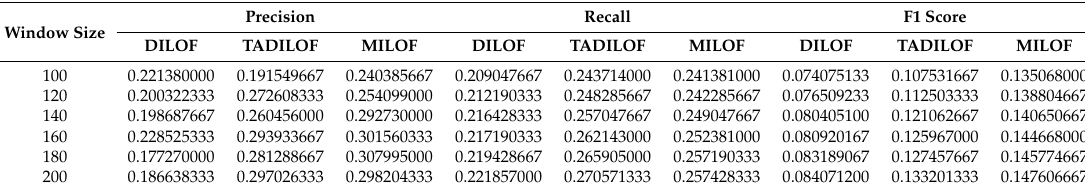
Table 5. Precision, recall, and F1 score on Mnist dataset.